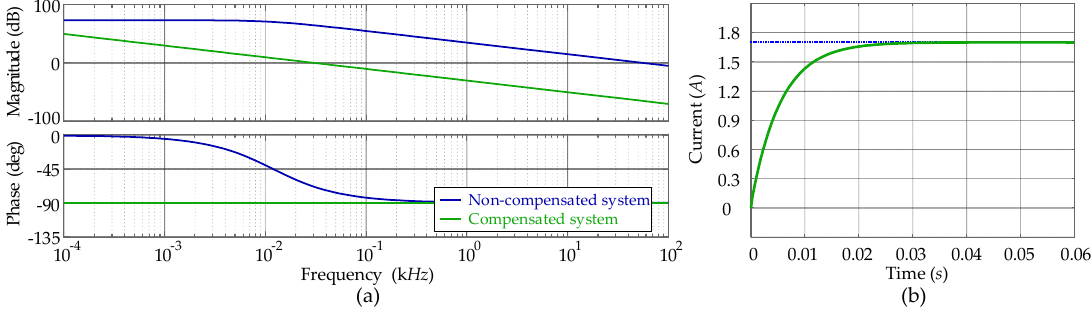
Figure 10. Simulation results: ( a ) Open-loop frequency response of the converter without compensator and with the compensator for the battery charging mode, ( b ) closed-loop step response.